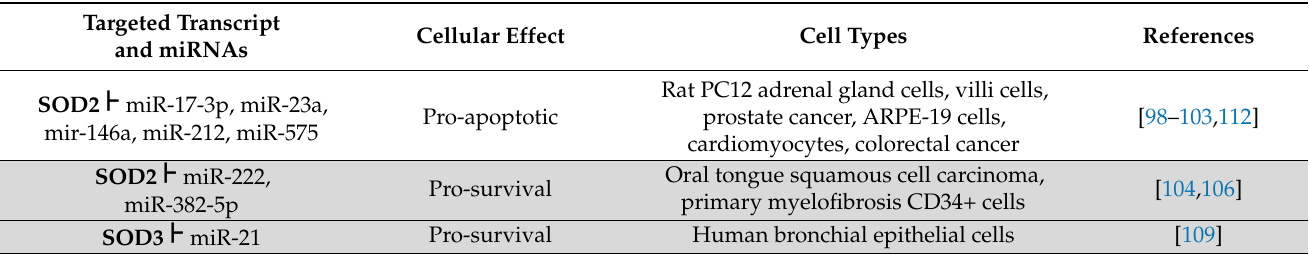
Table 2. Effects of increased levels of miRNAs which target transcripts of SOD enzymes. MiRNAs in grey rows have an opposite effect on cell survival to those in white rows.